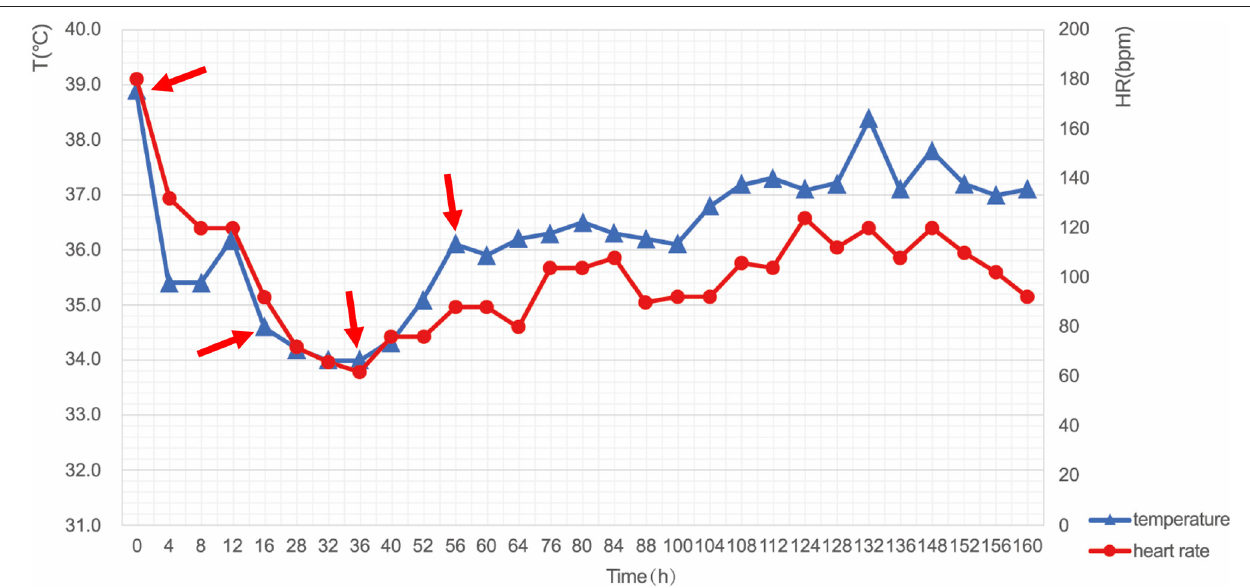
FIGURE 3 | Changes in body temperature and heart rate during TTM. The key moments included: start of cooling (Hour 0, 38.9 ◦ C), reaching the target temperature (Hour 12, 34.0 ◦ C), start of rewarming (Hour 36, 33.8 ◦ C), and end of rewarming (Hour 56, 36.5 ◦ C). T, temperature; HR, heart rate; TTM, targeted temperature